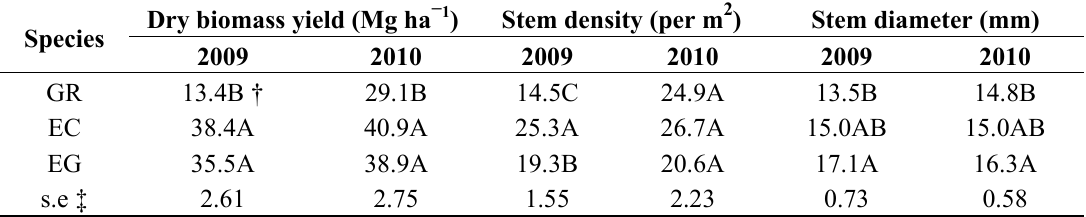
Table 2. Treatment means for annual aboveground crop biomass yield, stem density, and stem diameter of perennial grasses during the 2009 and 2010 growing seasons. Species include giant reed (GR), energycane (EC), and elephantgrass